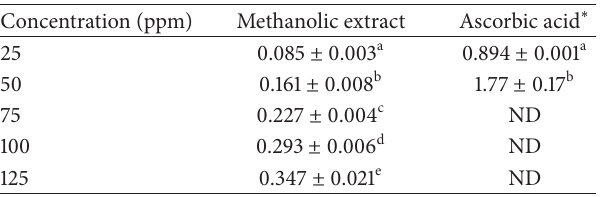
Table 1: Reducing potential of methanolic extract of stem of Plectranthus amboinicus